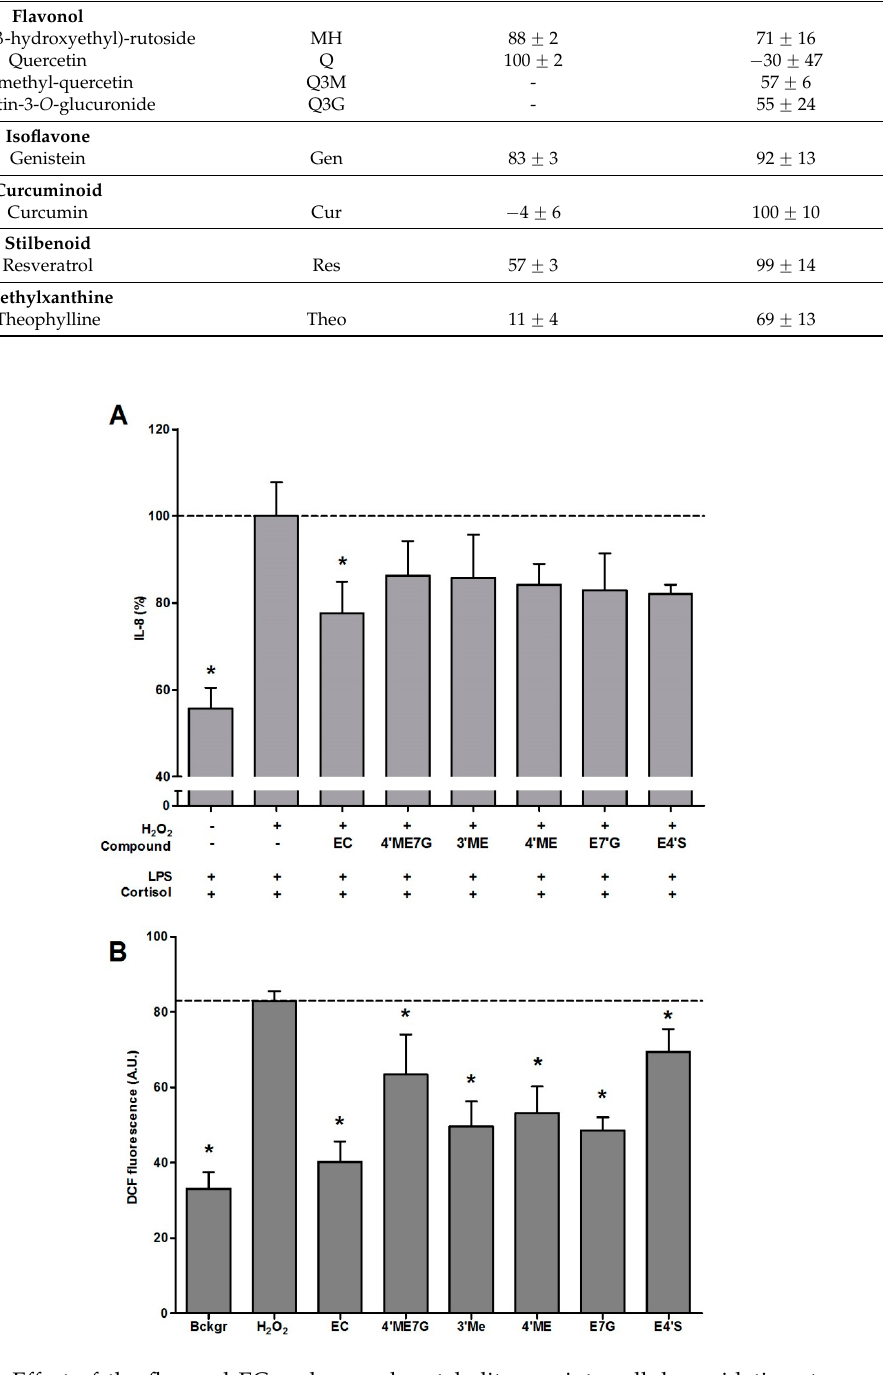
Figure 2. Effect of the flavanol EC and several metabolites on intracellular oxidative stress and glucocorticoid resistance. ( A ) Cells were pre-incubated with H 2 O 2 (800 µM) ± flavanols (10 µM) for 1 h and subsequently exposed to LPS (10 ng/mL) and cortisol (100 nM) for 16 h. IL-8 levels (%) were measured in the cell medium ( N = 6, mean ± SEM); ( B ) Intracellular oxidative stress. Differentiated monocytes were incubated with DCFH for 45 min, exposed to H 2 O 2 (800 µM) ± flavanols and fluorescence was measured for 1 h ( N = 4, mean ± SD, * p < 0.05 Dunnett’s). The dotted line represents IL-8 production or fluorescence of cells pre-incubated with H 2 O 2 (800 µM) without the bioactives, and subsequently exposed to LPS (10 ng/mL) and cortisol (100 nM).